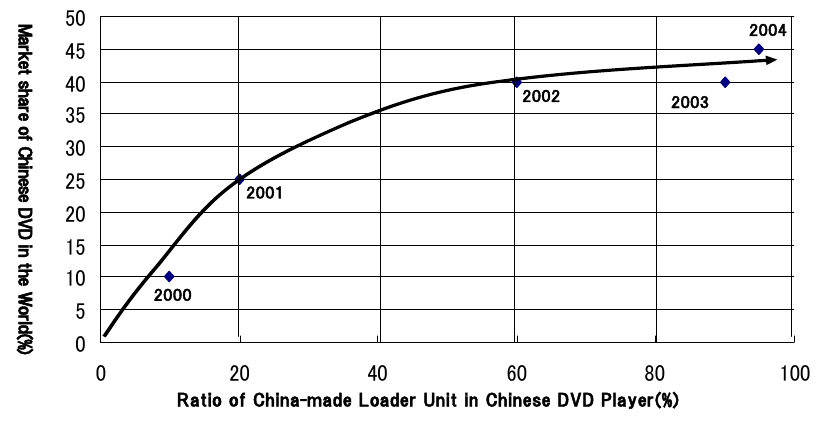
Figure 10. Contribution of China-made Loader to Rapid Progress of Chinese DVD